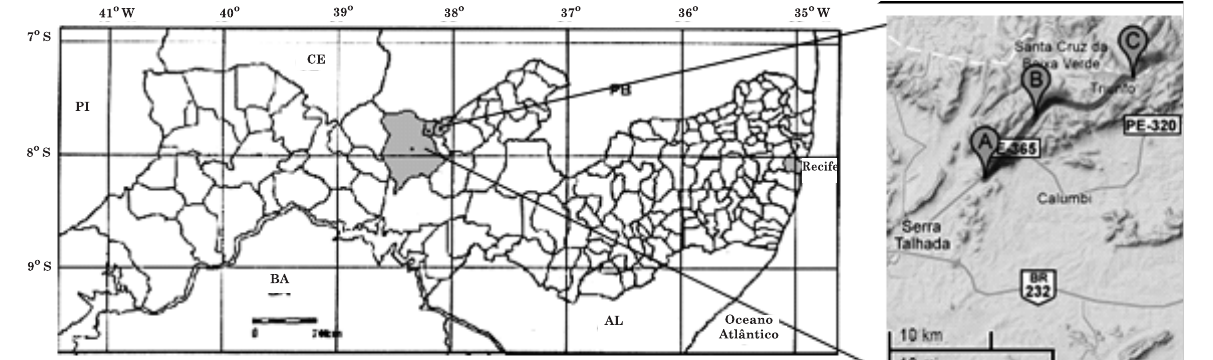
Figura 1. Mapa com a localização das áreas amostradas (Adaptado de Oliveira et al., 2003; Google © Dados Cartográficos, 2010). A: P1, B: P2 e C: